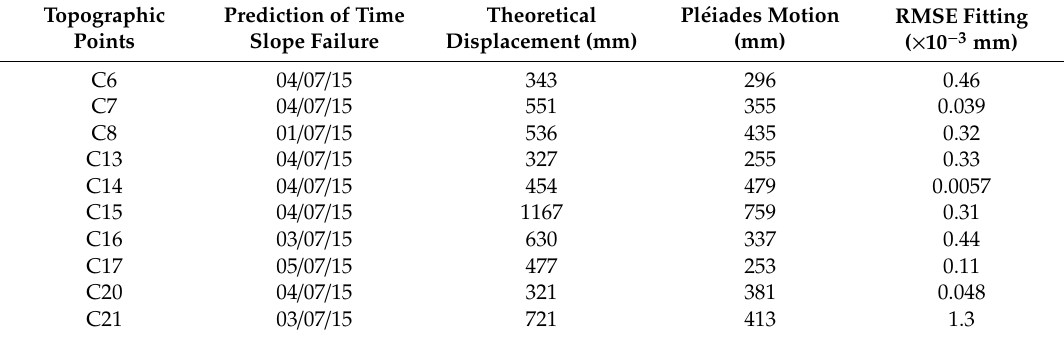
Table 1. Prediction of time slope failure and comparison between the theoretical displacements and the Pl é iades motion in mm. The RMSE is calculated from the di ff erence between the theoretical displacements and the linear function